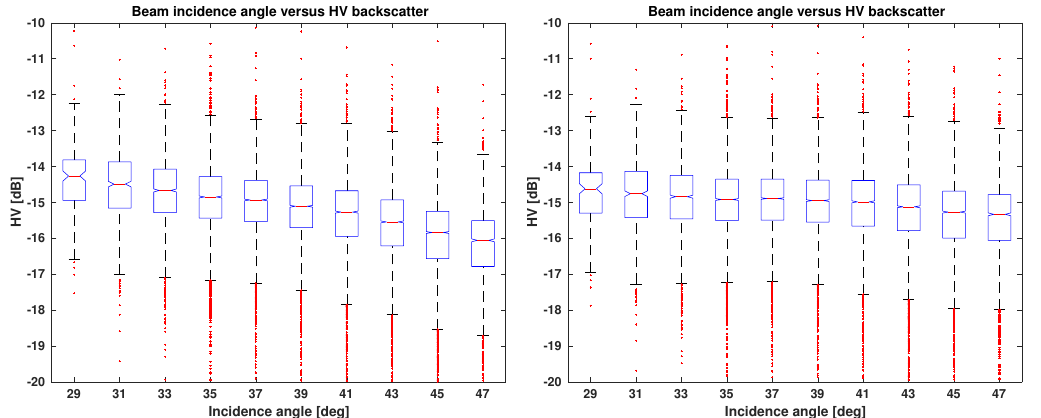
Figure 8. S1 EW HV backscatter versus incidence angles, before incidence-angle correction ( left ) and after incidence-angle correction ( right